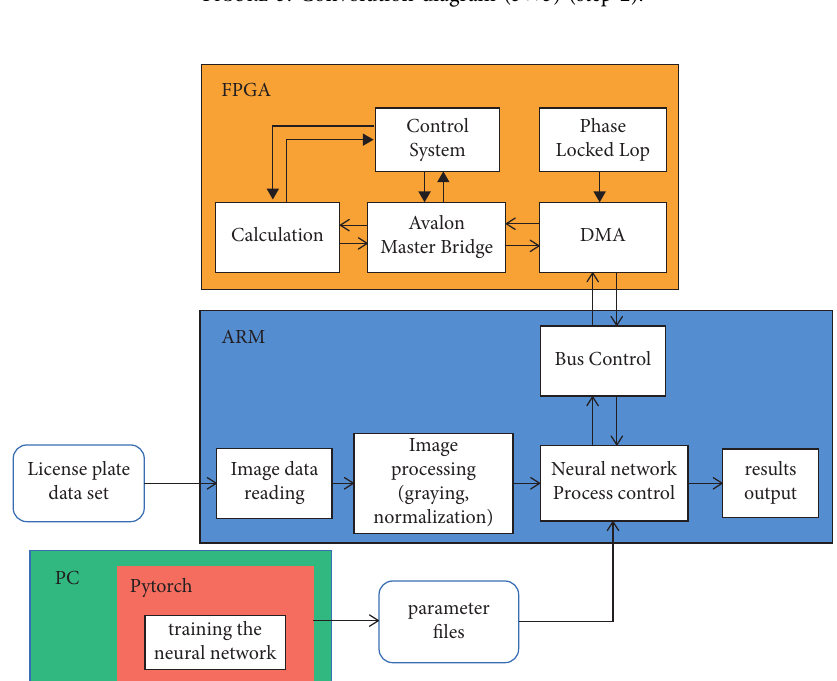
Figure 6: System framework